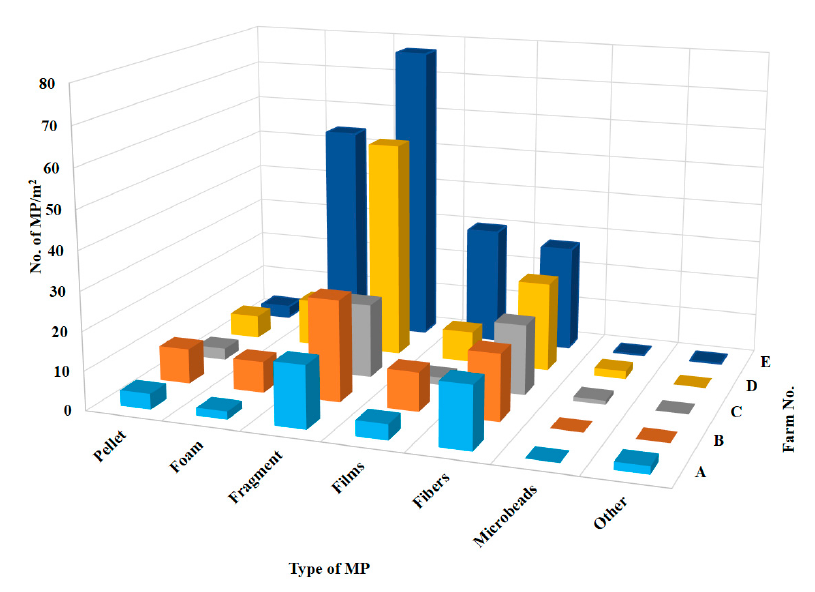
Figure 8. Type distribution of MPs detected in the studied farmlands.